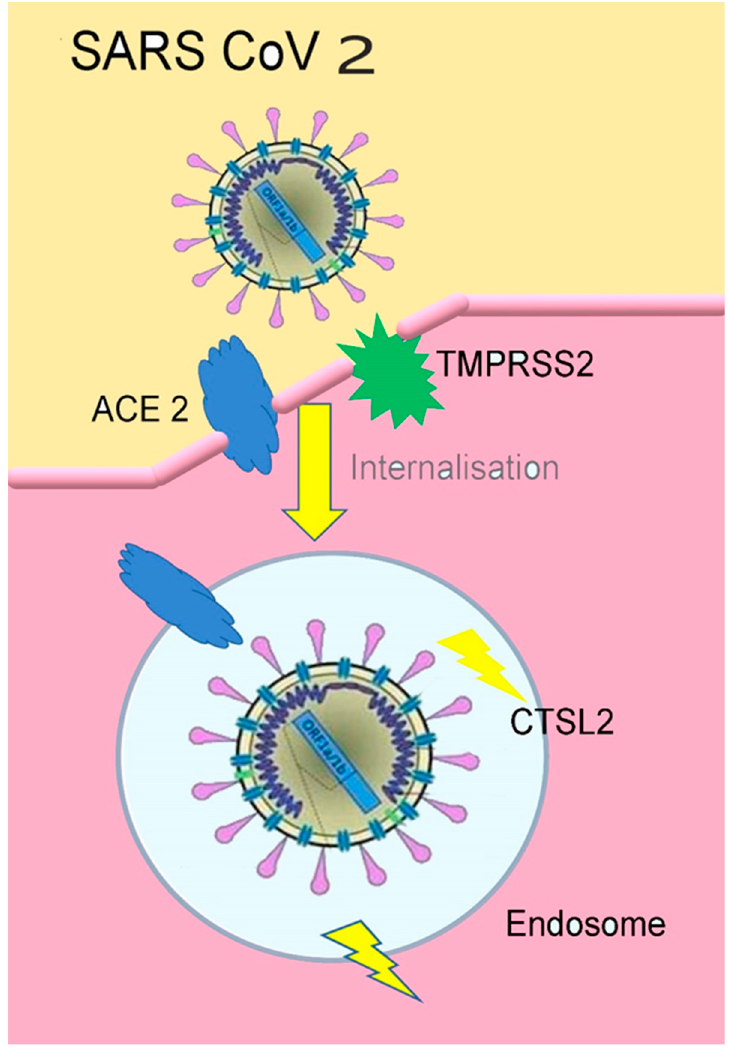
Figure 3. The connection of SARS-CoV2 to ACE2(figure inspired by https://www.the-scientist.com/news-opinion/receptors-for-sars-cov-2-present-in-wide-variety-of-human-cells-67496 [48], and drawn by Giovanna Dipalma) .